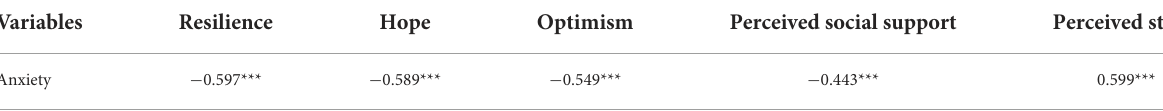
TABLE 4 Dyadic relations between anxiety and other psychological variables.